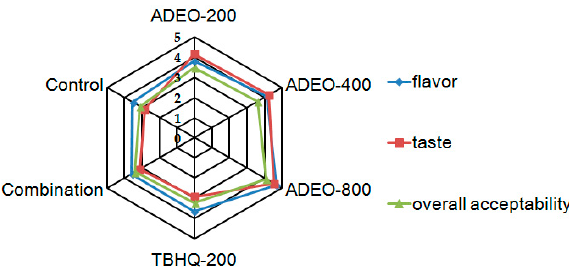
Figure 2. Sensory evaluation of sunflower oils samples influenced by ADEO: Values are expressed as means ± SD (n = 100) of flavor, taste, and overall acceptability. 301